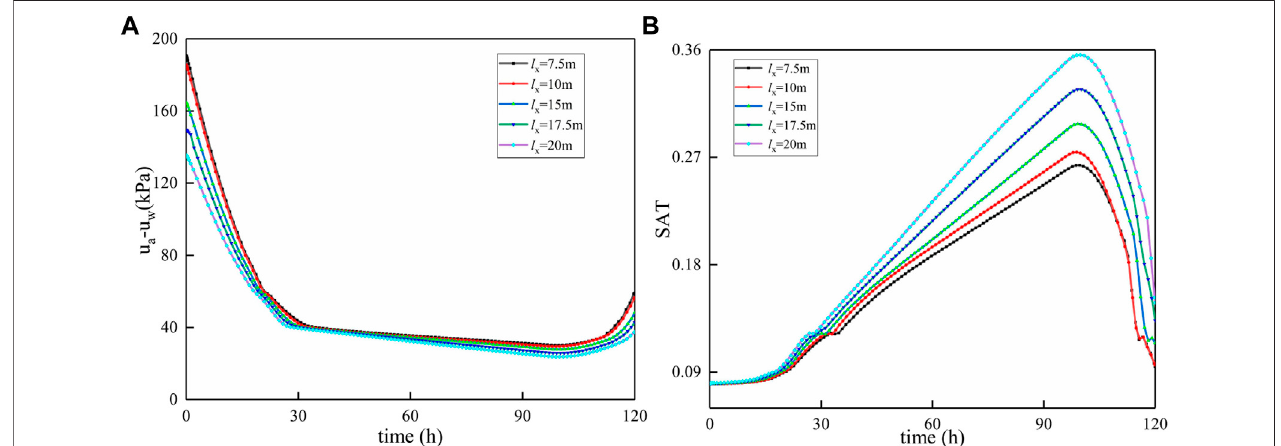
FIGURE 8 | Matrix suction and saturation at monitoring Unit D under different pile positions.